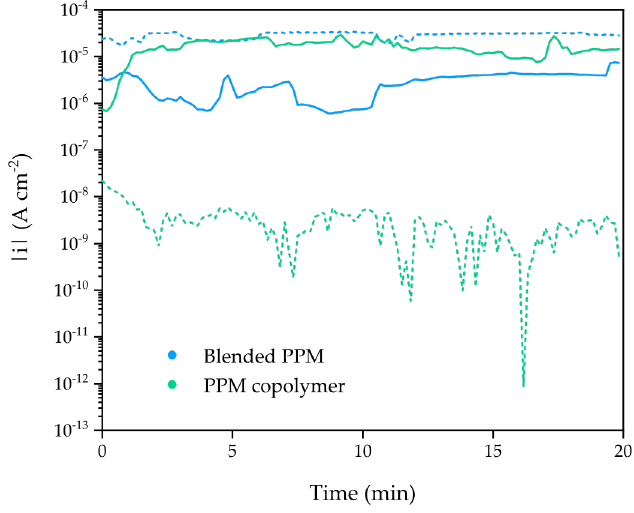
Figure 8. Current density (in logarithmic scale) of 30 µ m PPM-based coatings recorded during the first (solid line) and the last (dotted line) cathodic polarization at − 2 V vs. SCE. PPM copolymer coating is shown in green and the blended PPM in